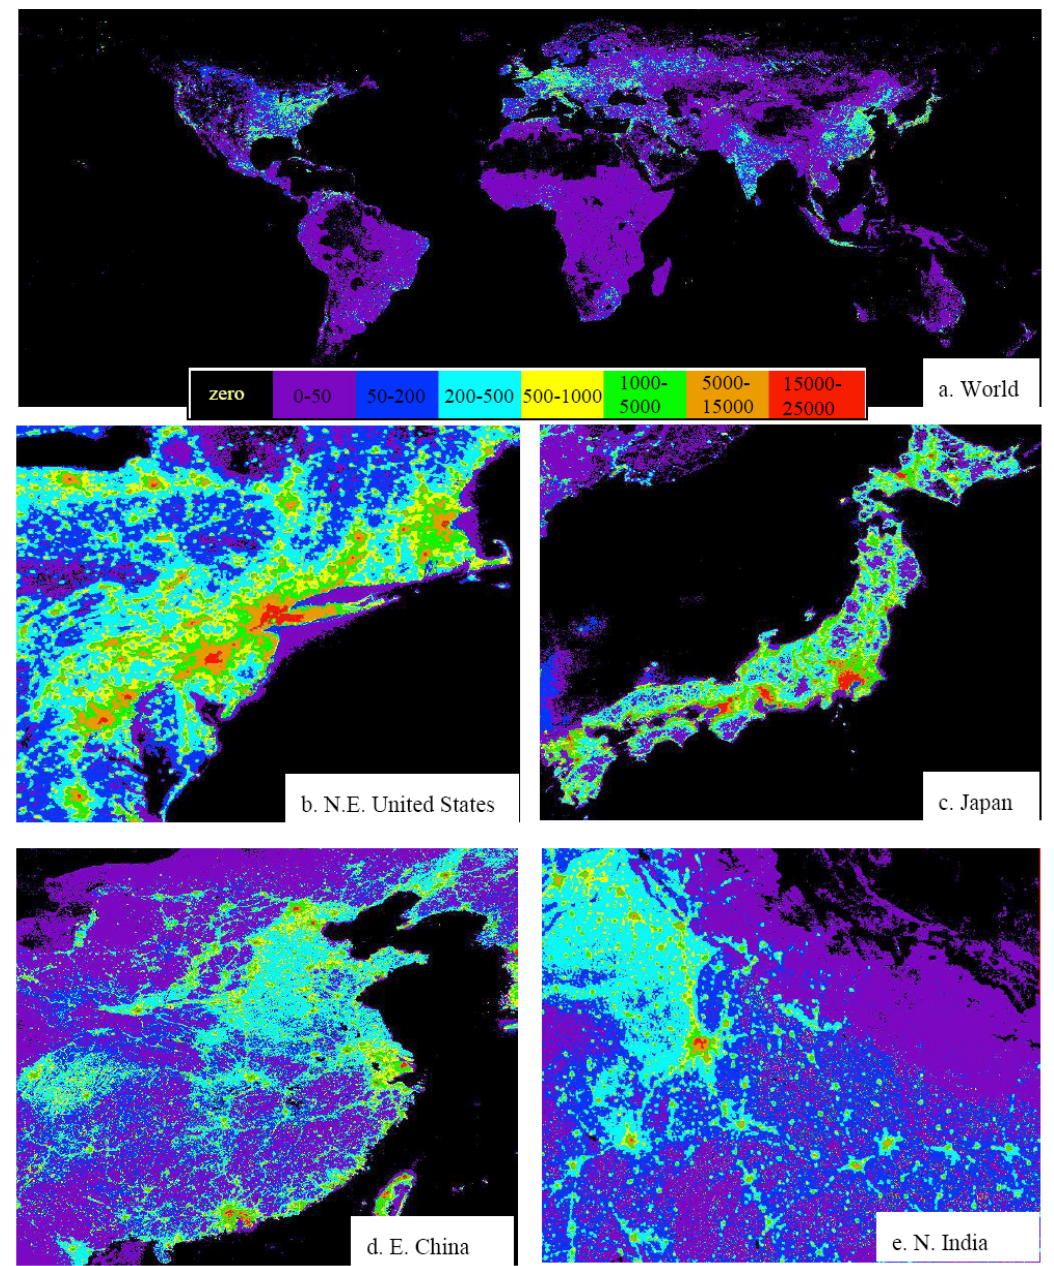
emissions grid in tonnes/km 2 2